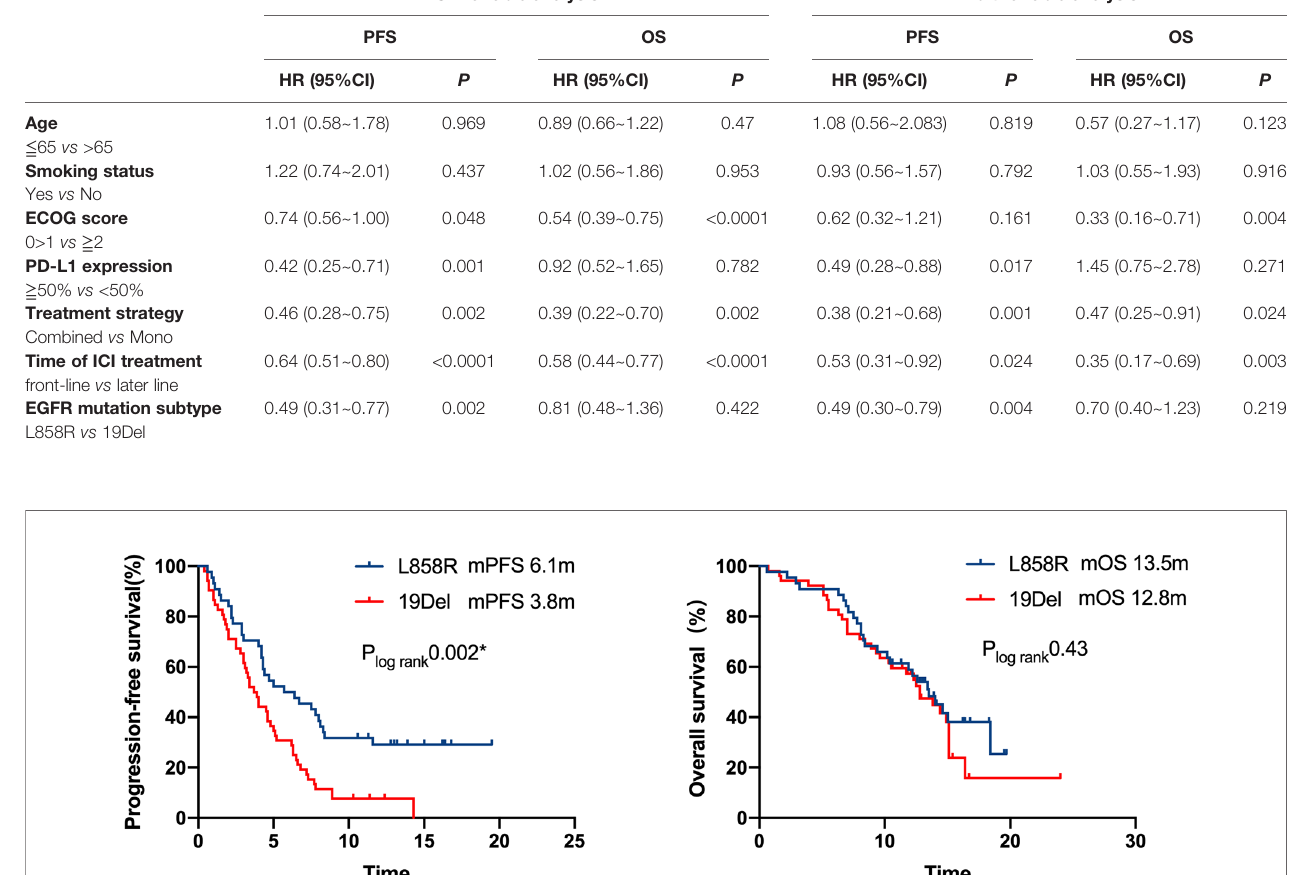
TABLE 3 | The univariable and multivariable analyses of PFS and OS among the EGFR common mutation population. Univariable analysis Multivariable analysis